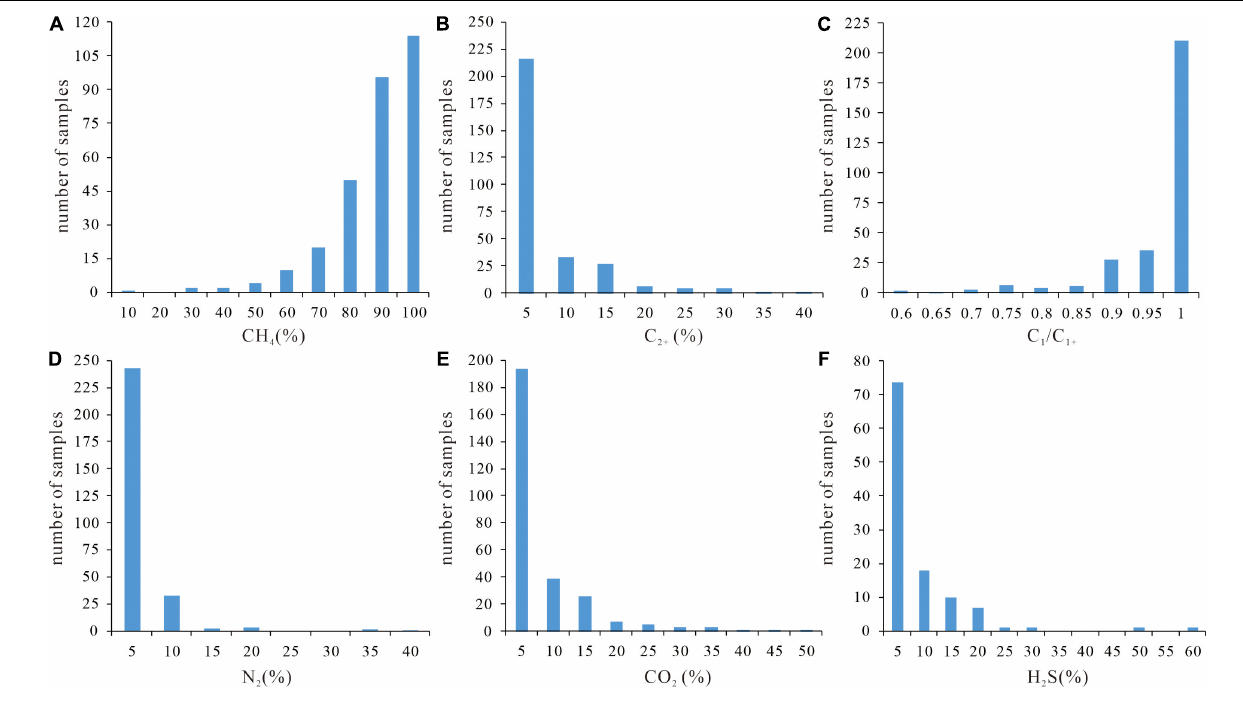
number ( δ 13 C 1 < δ 13 C 2 < δ 13 C 3 ). Samples from Sichuan